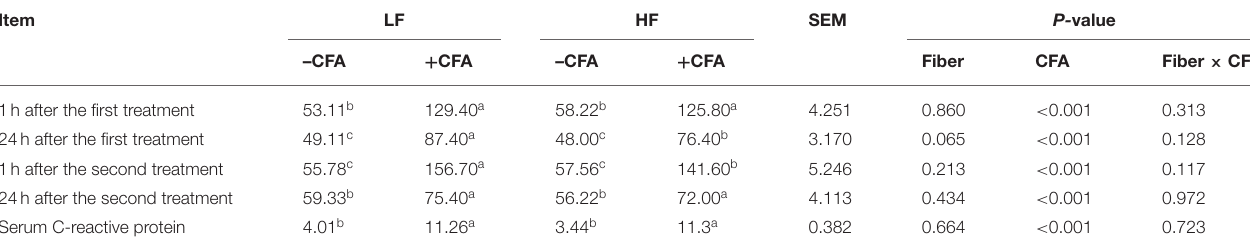
TABLE 5 | Effects of dietary fiber on respiratory rates and serum C-reactive protein in piglets after CFA challenge c . Item